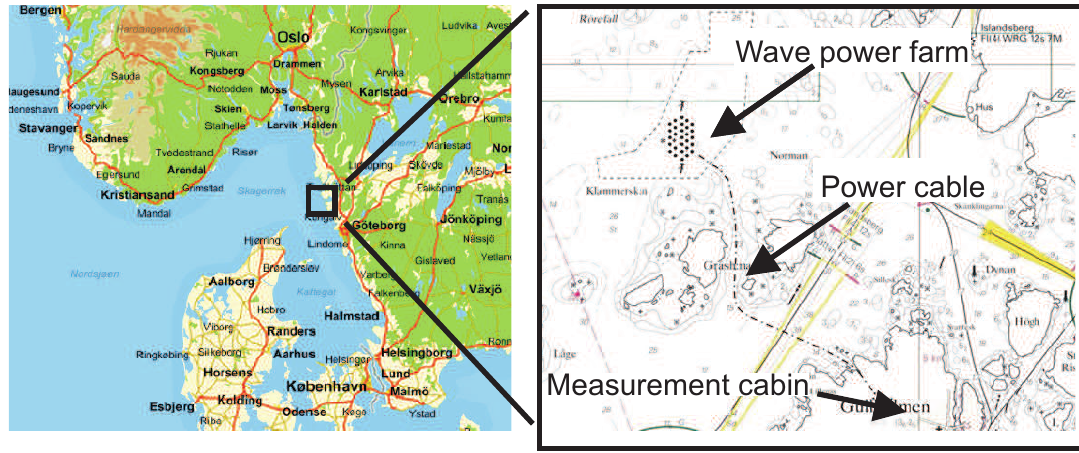
Figure 4. Location of the Lysekil test site.